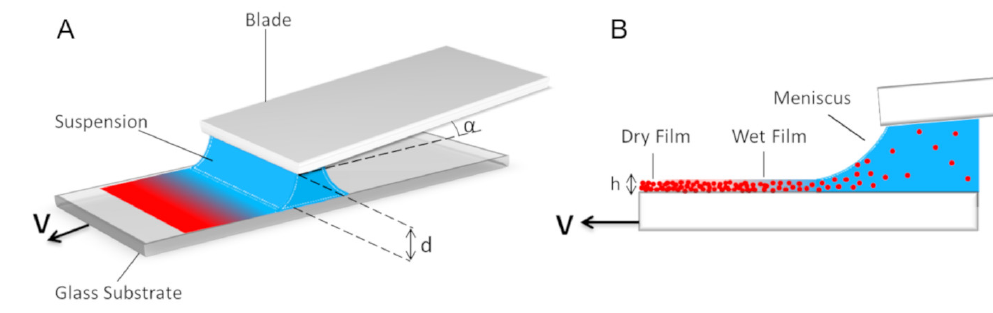
Figure 8. Sketch of the convective self-assembly (CSA) set-up: ( A ) A small volume of a dispersion of nanoparticles (the ‘reservoir’, in blue) is placed in-between a static blade and a substrate moving at controlled velocity v . ( B ) Side view of the geometry which leads to a deposit, in red, of controllable thickness h drying soon at the level of the meniscus [7,8]. The figures were reprinted with permission from Langmuir 2016, 32, 51, 13657–13668. Copyright 2016 American Chemical